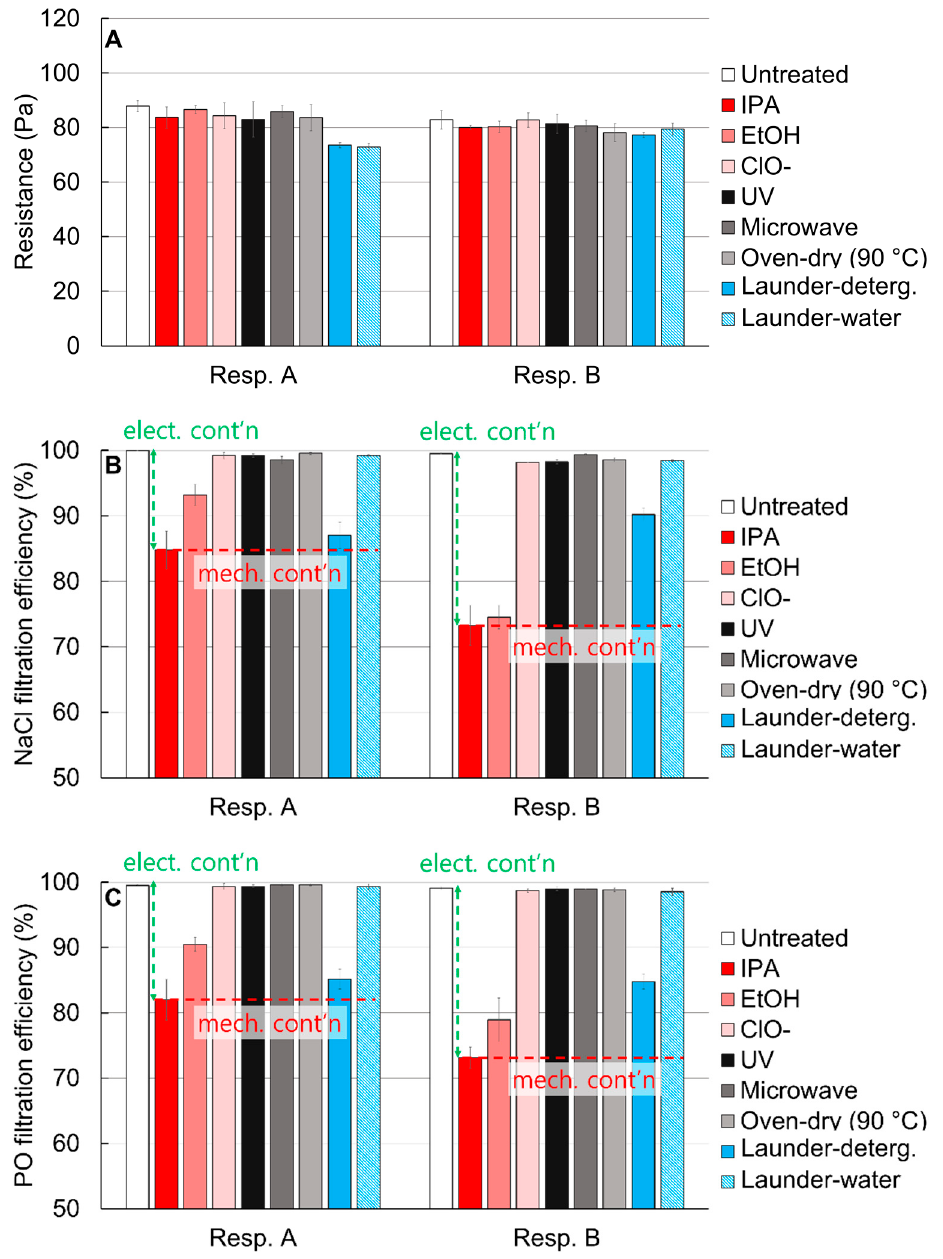
Figure 2. Filtration performance of respirators with varied disinfection treatments, corresponding to ( A ) resistance, filtration efficiency against ( B ) NaCl and ( C ) paraffin oil. The red dotted line indicates the presumed contribution of mechanical filtration, while the green dotted line indicates the contribution of electrostatic filtration.